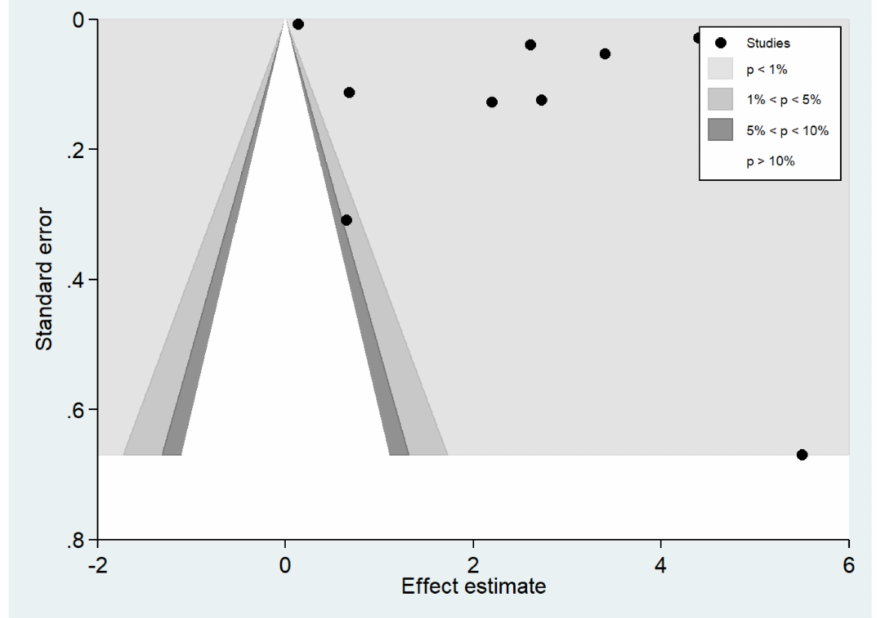
Figure 14. The contour-enhanced funnel plot demonstrated that the estimates (black dot) were located in the significant area ( p <